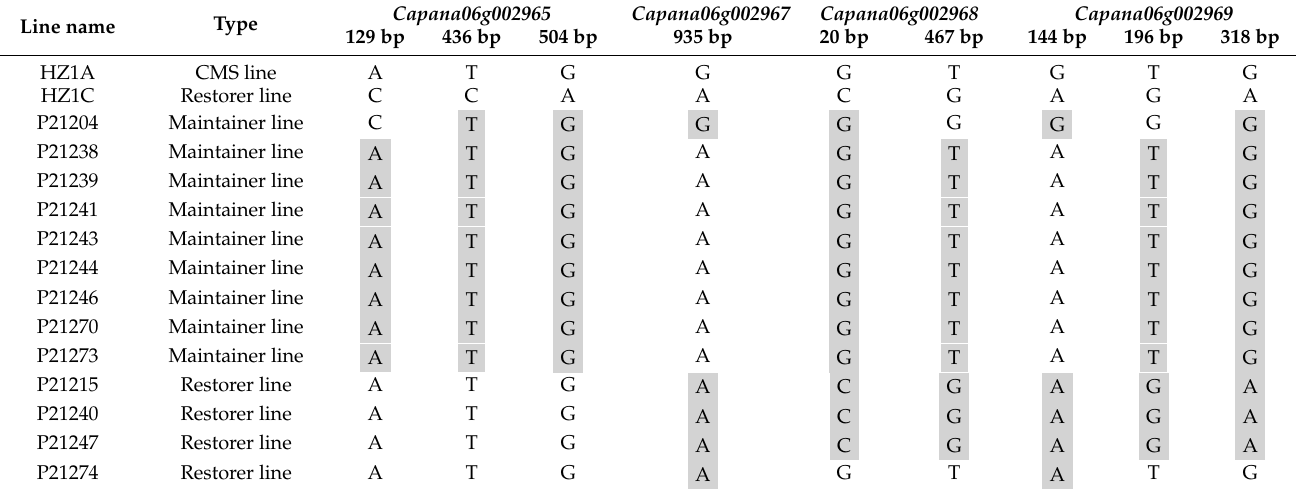
Table 5. The variations of four annotated genes in the CMS, maintainer, and restorer